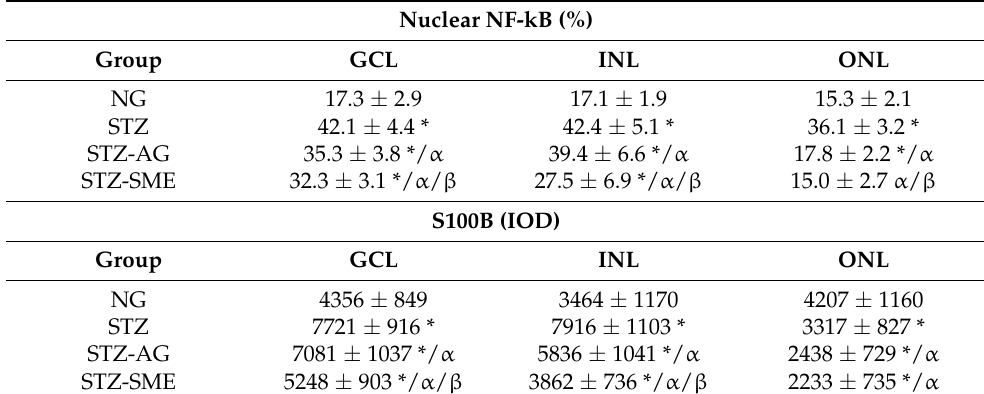
The percentage nuclear of NF- κ B staining and values IOD for S100B in the retinal layers (GCL, INL, and ONL) of NG, STZ, STZ-AG, and STZ-SME groups are shown. Data show mean ± SD. * p < 0.01 compared to NG; α p < 0.01 compared to STZ; and β p < 0.01 compared to